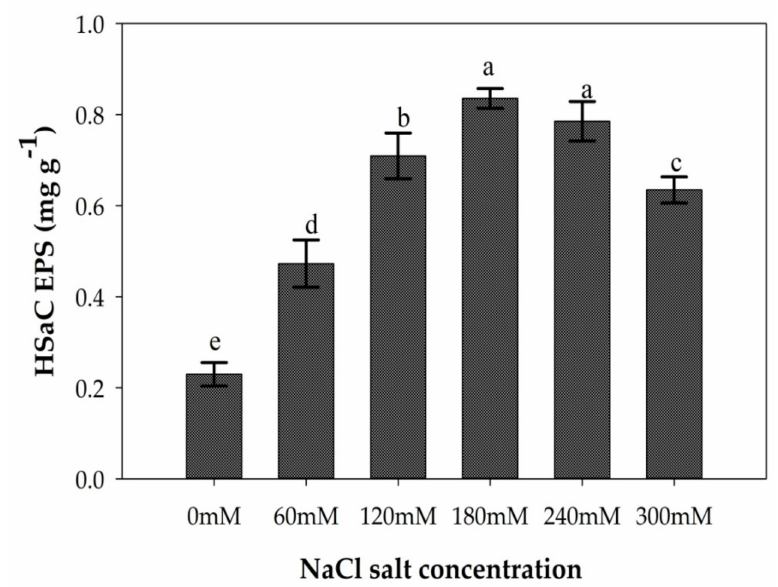
Figure 2. HSaC cyanobacterial exo-polysaccharide (EPS) content as influenced by di ff erent NaCl salt concentration (0 mM, 60 mM, 120 mM, 180 mM, 240 mM and 300 mM). The error bars represent standard deviation (SD). The data are the mean of the three replicates. Di ff ering letters indicate significant di ff erences in the means of HSaC cyanobacterial exo-polysaccharide content pairwise comparisons (Tukey’s test p < 0.05) for each treatment by